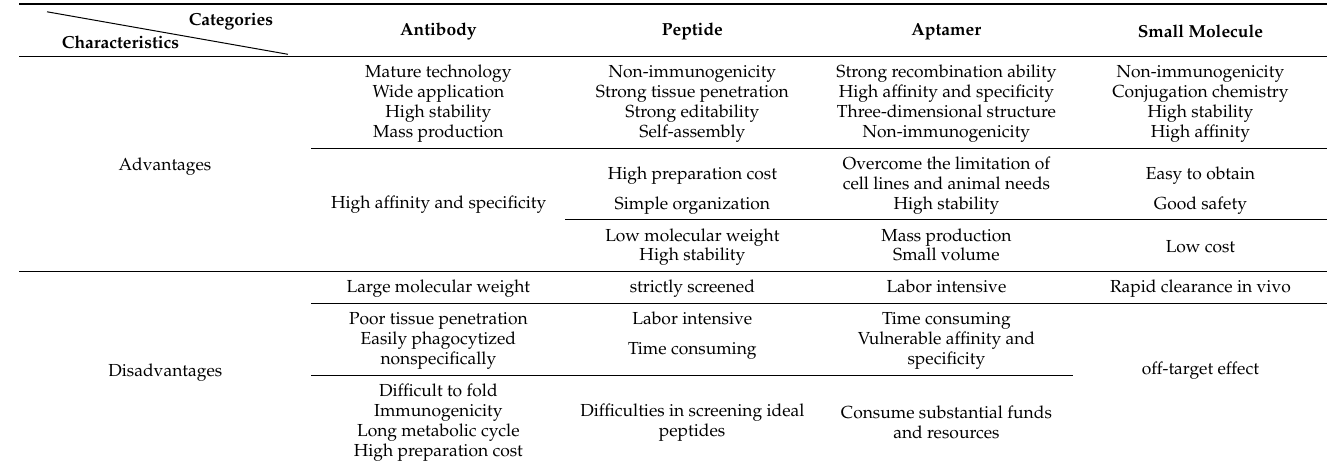
Table 3. The advantages and disadvantages of common ligand